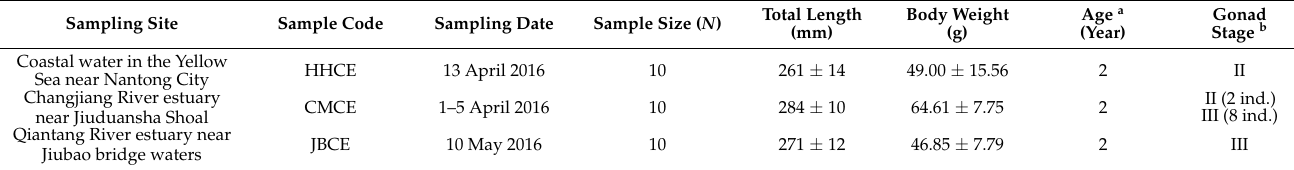
Table 1. Sampling details of Coilia nasus in the present